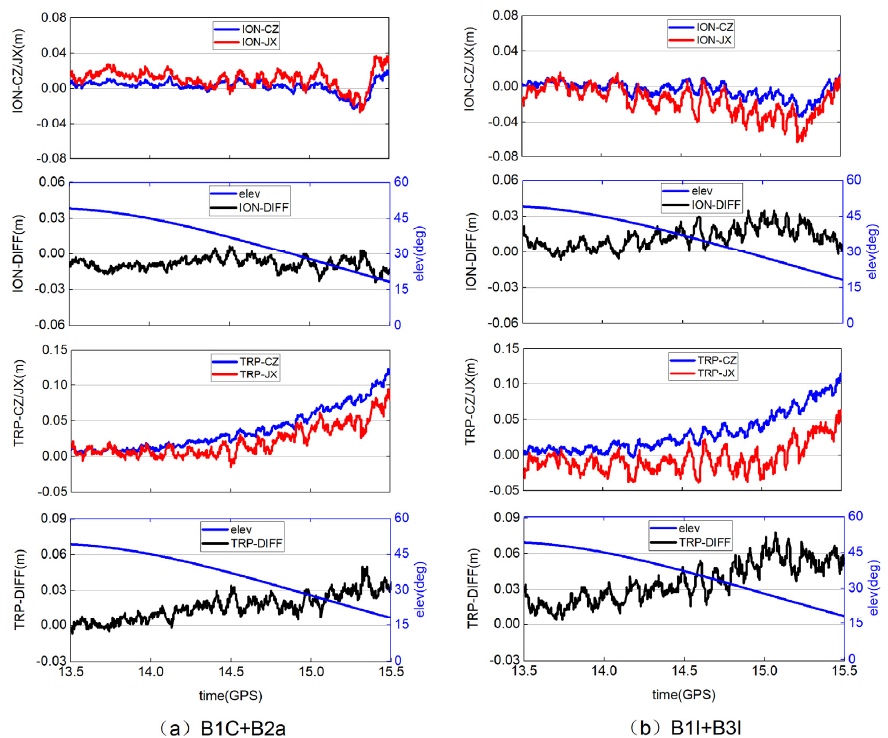
Figure 7. Comparison of atmospheric modeling value and reference value of B33 satellite at SC17. Station (CZ modeling value/JX reference value/DIFF mutual difference of two values). Table 5. RMS Statistics of atmospheric modeling values and reference values at Station SC17 under different frequency signal combinations (m).